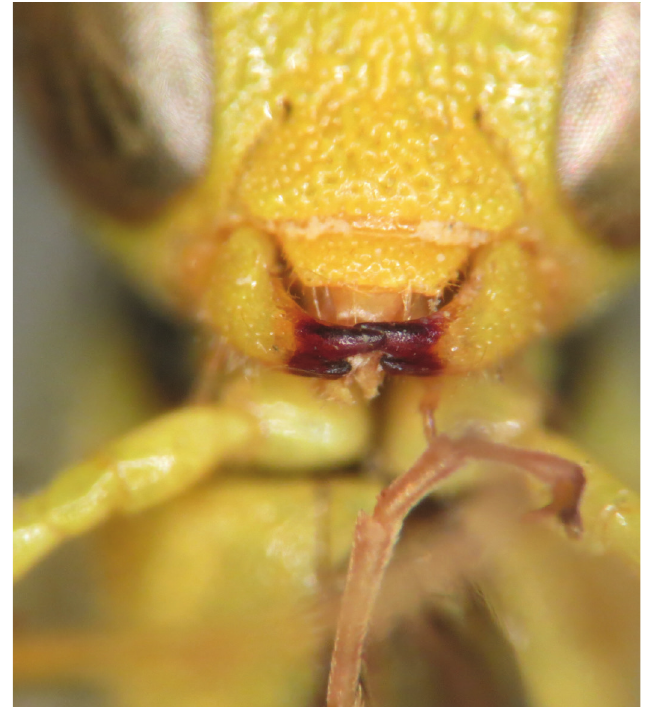
Figure 7. Hellwigia elegans , mandibles, labrum, clypeus (Turkey).